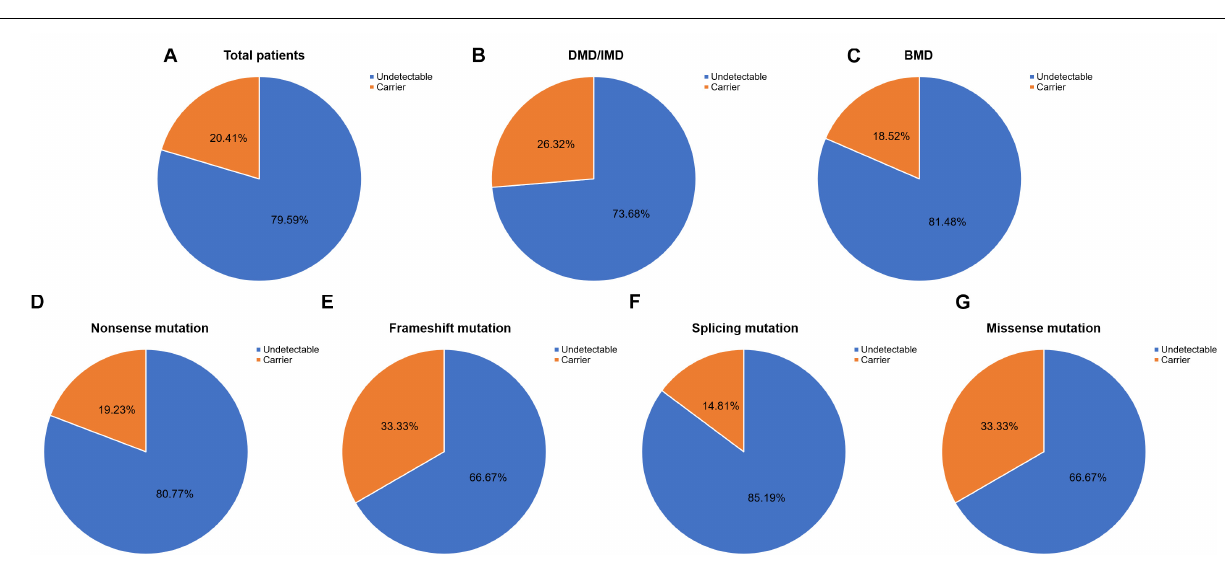
FIGURE 2 | Carrier status of probands’ mothers. Carrier status ratios for mothers of (A) all probands, (B) DMD/IMD, and (C) BMD as well as probands with the following different mutation types, (D) nonsense, (E) frameshift, (F) splicing, and (G) missense